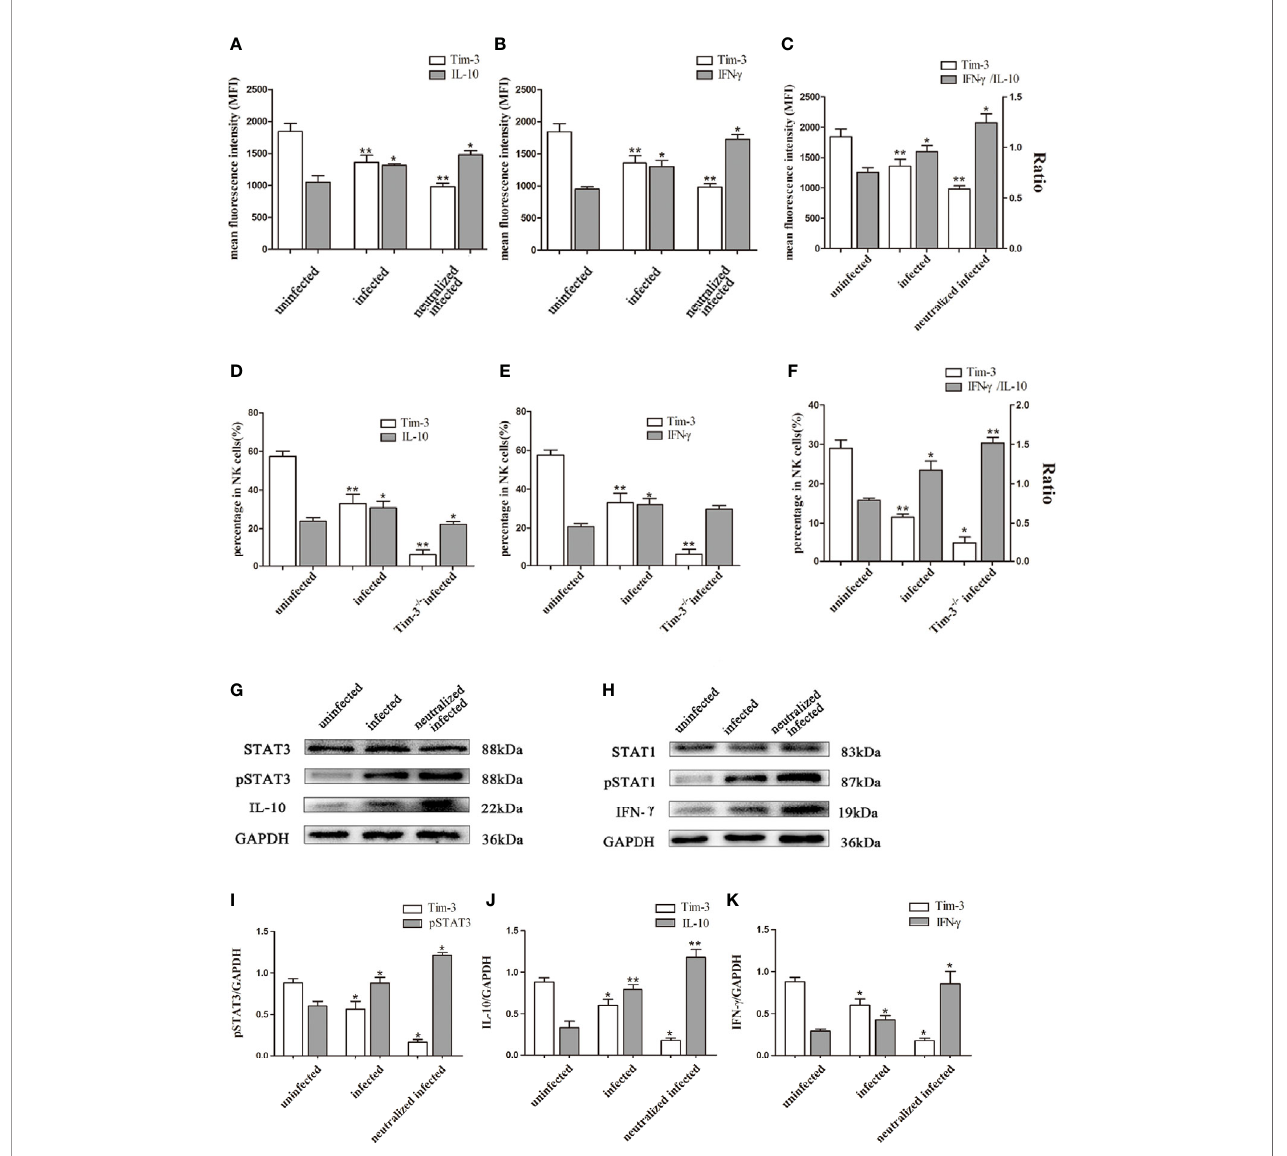
FIGURE 6 | Down-regulation of Tim-3 by T. gondii infection affected IL-10 and IFN- g secretion in dNK cells. (A-C) The human dNK cells expression levels of Tim-3, IL-10 (A) , IFN- g (B) and IFN- g /IL-10 ratios (C) among uninfected, infected, and anti-Tim-3 neutralized infected groups were detected by fl ow cytometry. (D-F) Tim-3, IL-10 (D) , IFN- g (E) expression changes and ratios of IFN- g /IL-10 (F) in uninfected, infected, and Tim-3 -/- infected mice dNK cells were showed by fl ow cytometry. (Means ± SD; N=6 human samples per group, in vitro ; N=8 mice per group, in vivo , * p < 0.05, ** p < 0.01, by unpaired t -test). (G) STAT3 and pSTAT3 involved in the regulation of IL-10 secretion were detected by western blot among uninfected, infected, and anti-Tim-3 neutralized infected groups. (H) STAT1 and pSTAT1 which were associated with IFN- g expression in dNK cells were detected by western blot in uninfected, infected, and anti-Tim-3 neutralized infected groups. The data of STAT1 and pSTAT1 in Figure 5H reused the data in Figure 4G for Perforin and IFN- g shares the same upstream molecules STAT1 and pSTAT1, and the detection was conducted simultaneously. (I-K) Histograms analysis of pSTAT3, IL-10 and IFN- g in uninfected, infected, and anti-Tim-3 neutralized infected groups. (Means ± SD; N=6 human samples per group, * p < 0.05, ** p < 0.01, by unpaired t